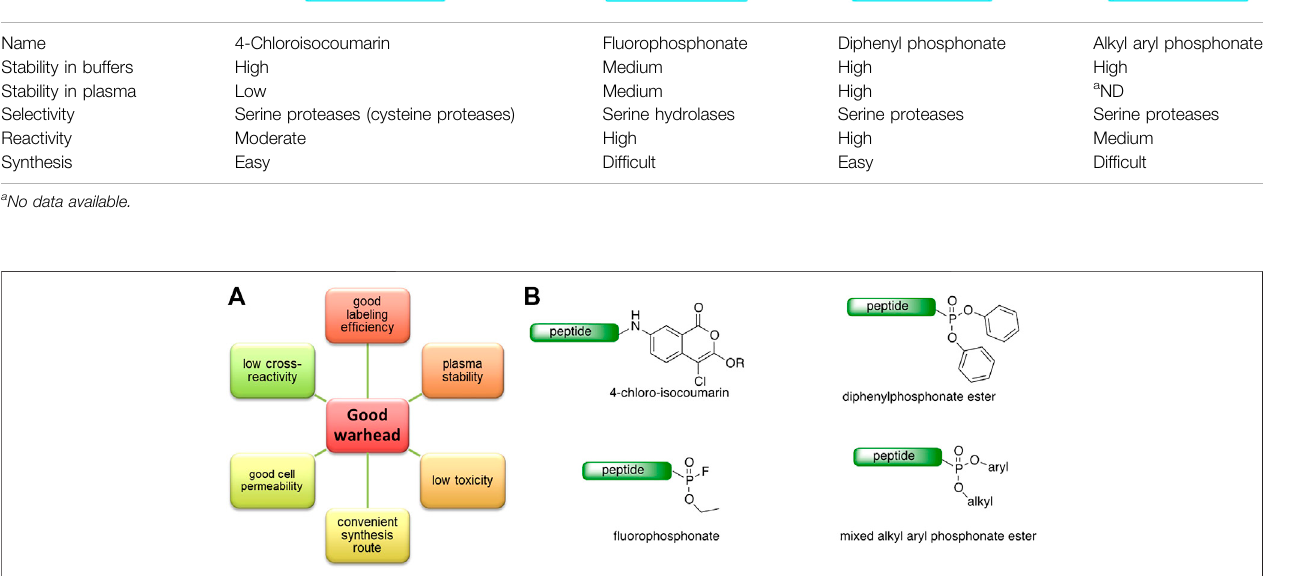
Warhead scaffold